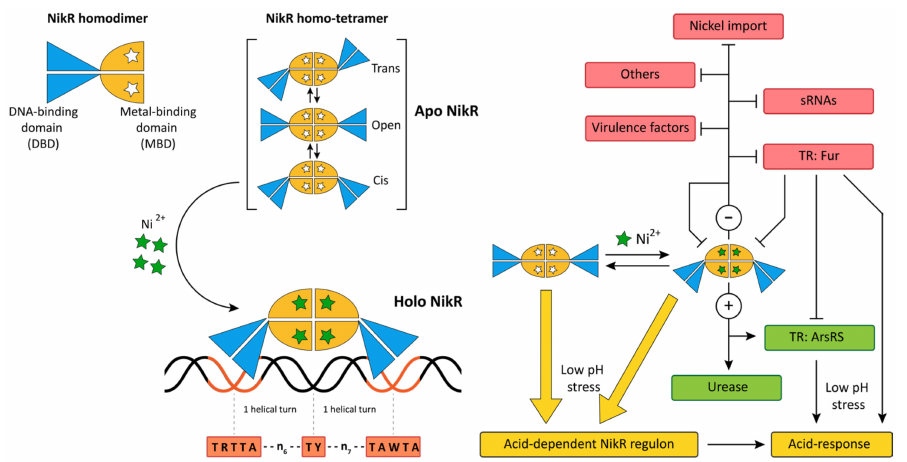
Figure 2. Schematic representation of NikR regulation. On the left part of the figure, a cartoon representation of NikR homodimer, homo-tetramer, and the Ni 2+ -mediated transition to holo-NikR, with the latter interacting with the reported operator consensus sequence. On the right part of the figure, the network connects NikR to its target set of genes. Symbols are as indicated in the legend in Figure